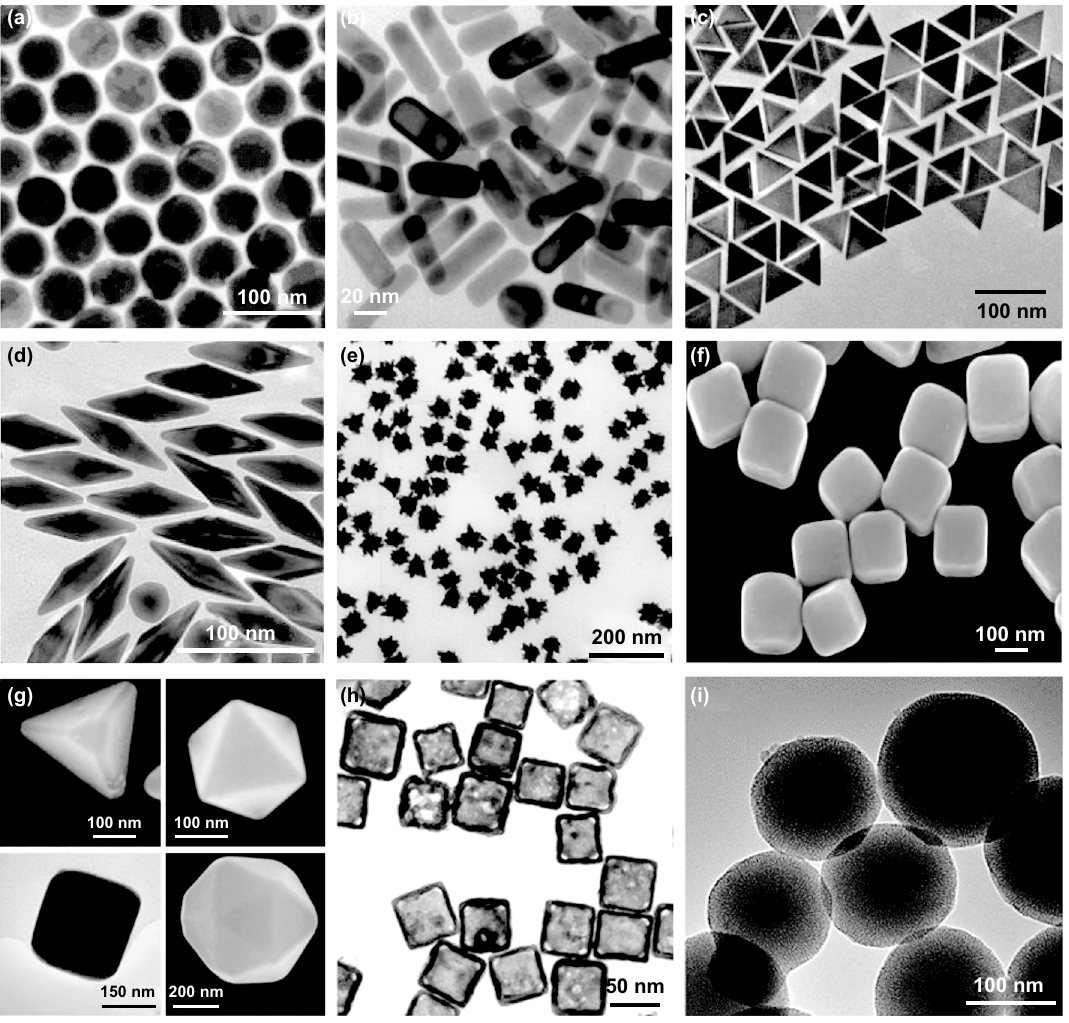
Fig. 2 AuNPs synthesized with different shapes following bottom‑up approaches: a spheres [32]. Copyright 2013 Wiley–VCH Verlag GmbH & Co. KGaA; b rods [34]. Copyright 2011 The Royal Society of Chemistry; c prisms [37]. Copyright 2015 The Royal Society of Chemistry; d bip‑ yramids [42]. Copyright 2016 Fang et al.; e stars [38]. Copyright 2008 IOP Publishing Ltd.; f cubes [35]. Copyright 2002 Sun et al.; g polygon‑ shaped nanocrystals [40]. Copyright 2004 Wiley–VCH Verlag GmbH & Co. KgaA; h cages [39]. Copyright 2010 Wiley–VCH Verlag GmbH & Co. KgaA; i gold@silica hybrid nanoparticles [43]. Copyright 2019 Vega et